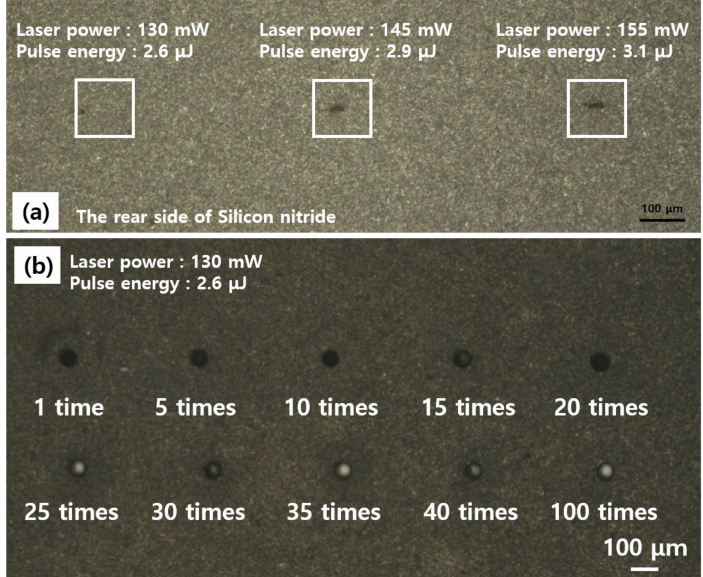
Figure 3. ( a ) Images of the back side of silicon nitride comparing the penetration power at laser power of 130 mW, 145 mW, and 155 mW; ( b ) comparison of holes obtained after 1 to 100 processing cycles at laser powers of 130 mW.